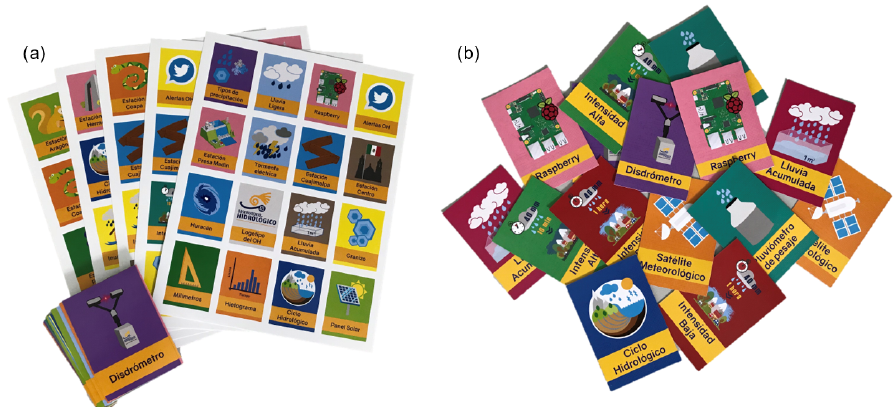
Figure 2. Water bingo boards and cards (a) and memory cards (b) designed for the workshop.